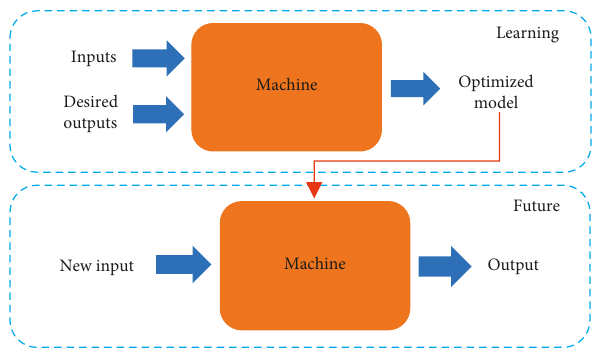
Figure 4: Basic diagram of supervised learning